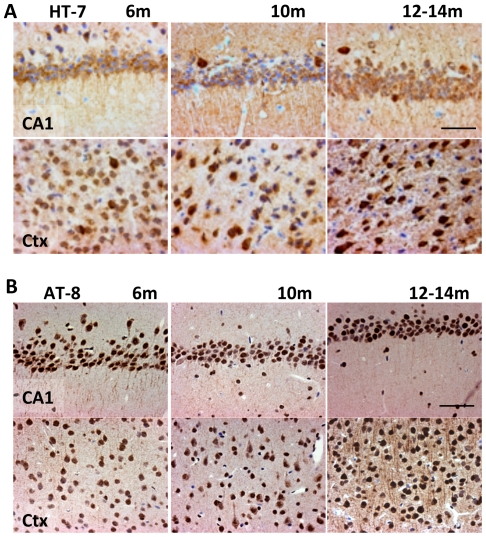
Tau histopathology in PLB1Triple mice.Immunocytochemcial labelling for human tau (HT-7 antibody, A) as well as phospho-tau (AT-8, B), revealed positive staining in somata and processes in CA1 and cortical neurones from 6 months onwards in PLB1Triple mice.